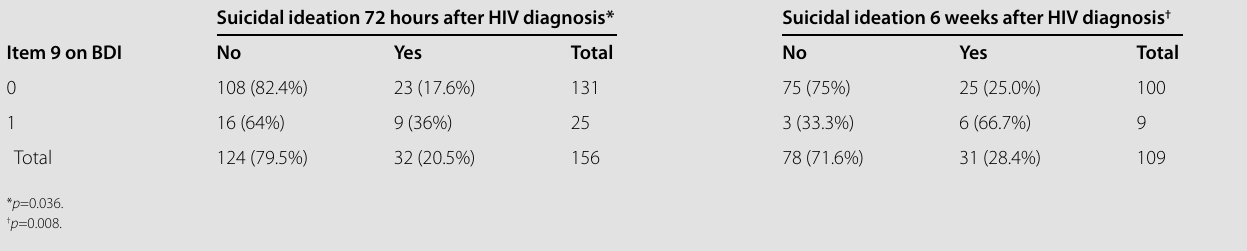
Table 1. The association between suicidal ideation on the BHS scores and item 9 on the BDI 72 hours and 6 weeks after HIV test results Suicidal ideation 72 hours after HIV